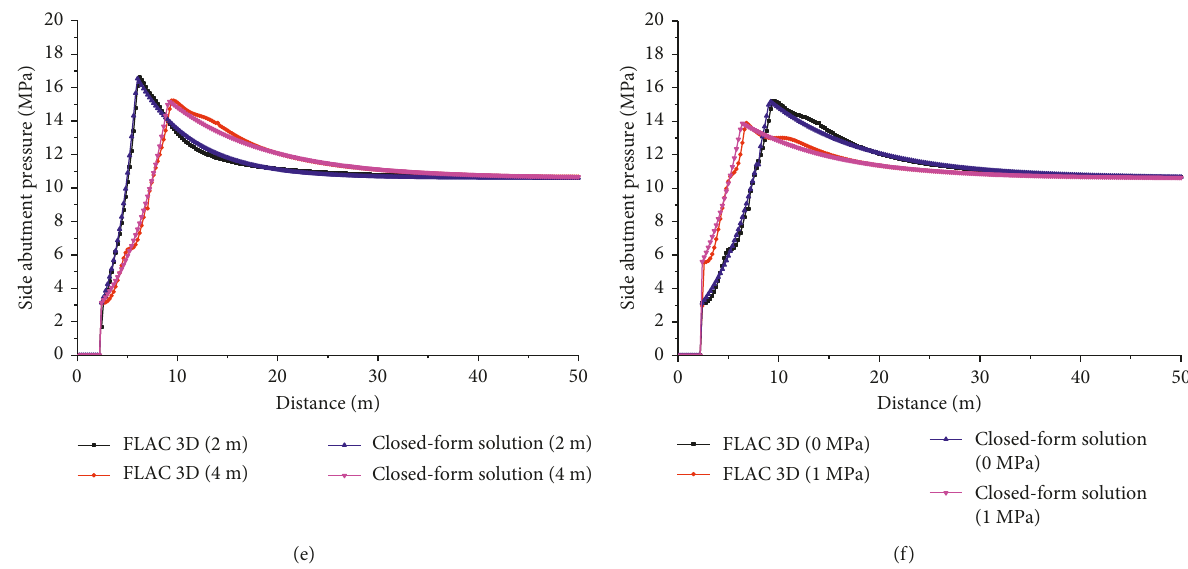
Figure 3: The side abutment pressure distribution. (a) The interfacial friction angle. (b) The interfacial cohesion. (c) The friction angle of the coal. (d) The cohesion of the coal. (e) The roadway height. (f) The support